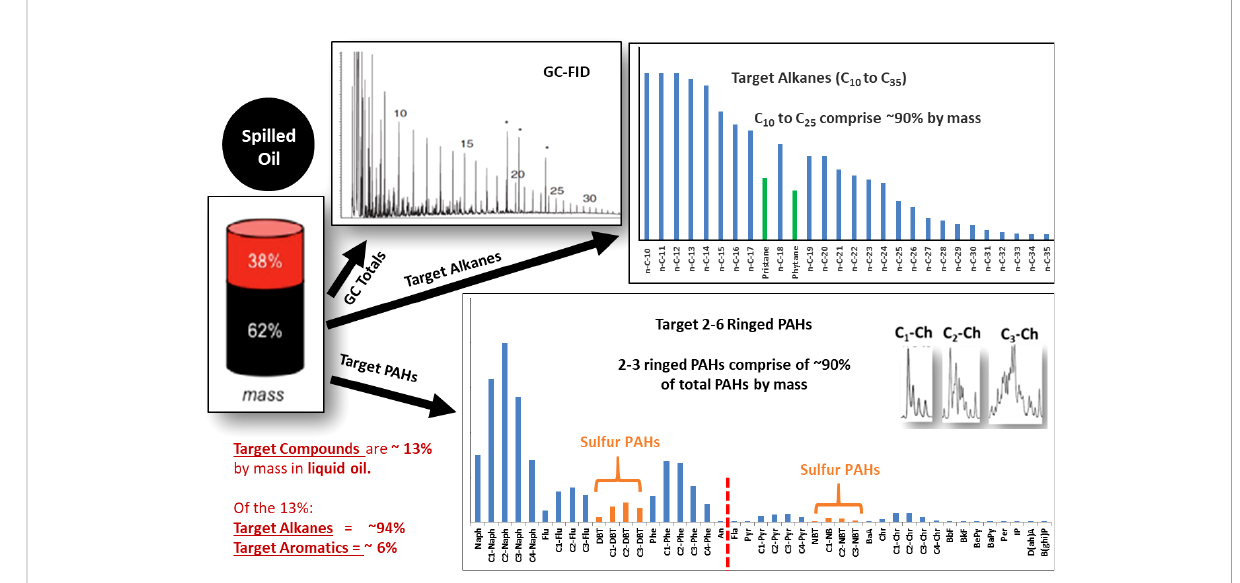
FIGURE 4 The composition of the liquid source oil spilled from the Macondo well blowout obtained from gas chromatographic analysis using Flame Ionization Detector (GC-FID, from Stout et al., 2016) and Mass Spectrometer operating in the Selected Ion Monitoring mode (GCMS-SIM). The GC-FID chromatogram shows the full range of hydrocarbon compounds in this liquid oil, from ~n-C 4 to n-C 36+ including benzene and the C 1 and C 2 alkyl benzenes. Most hydrocarbons in oil samples are analyzed by GCMS analytical techniques that can quantitate selected speci fi c target analytes that include: a) normal alkanes from n-C 10 to n-C 35 + including isoprenoid compounds pristine and phytane; b) Polycyclic Aromatic Hydrocarbons (PAH) and their C 1 to C 3 or C 4 alkyl homologs as well as sulfur containing PAH compounds Dibenzothiophene and Naphthylbenzothiophene and their alkyl homologs. Additionally, the compositional isomer pro fi les of the C 1 to C 3 alkyl chrysenes are shown for the spilled Macondo oil. The target compounds account for ~13% of the weight of the liquid source oil, and saturate compounds represent ~94% of this weight while the target aromatics account for